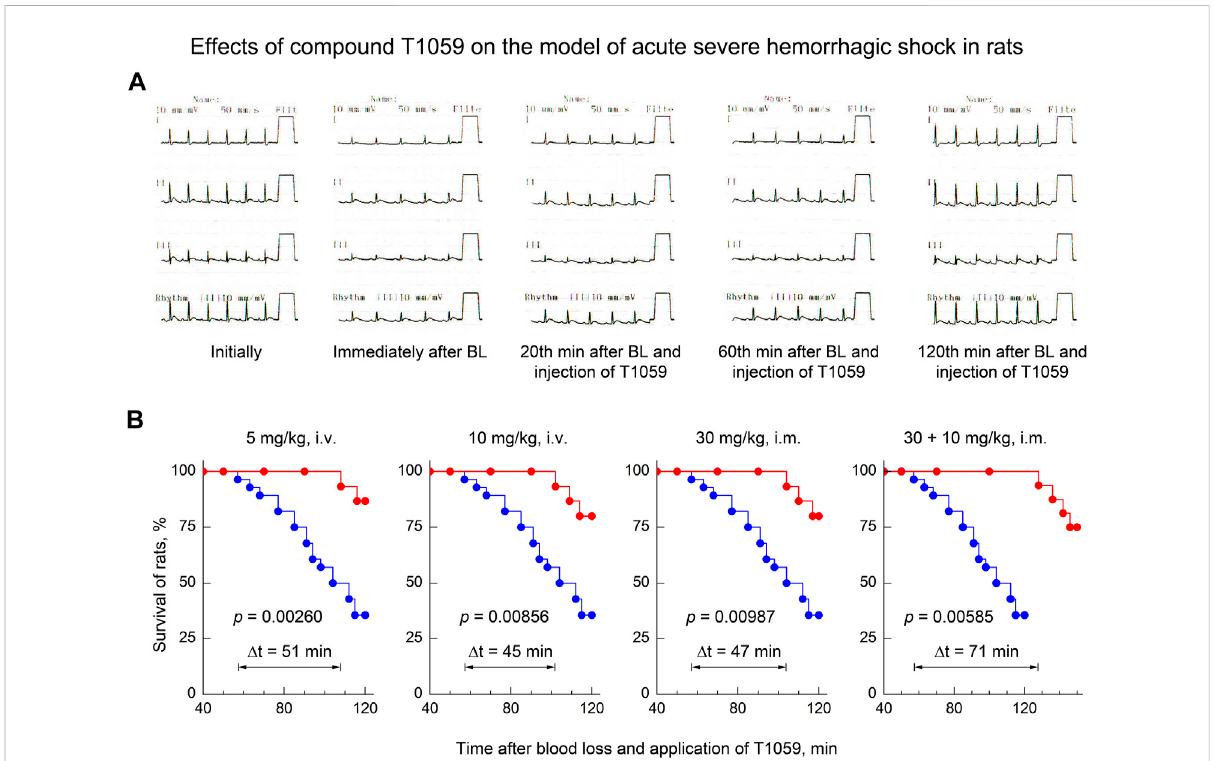
FIGURE 5 Effect of compound T1059 on the clinical course of the early stage of acute severe hemorrhagic shock in rats. (A) Typical cardio-respiratory dynamicsinT1059-treatedrats.Initially:BP — 128/84 mmHg;HF — 424 min-1;sinusrhythm,nochangesintheECG;RF — 58 min-1.Immediatelyafter blood loss (BL): BP — 53/27; HF — 335; sinus rhythm, R-wave depression; RF — 63. 20 min after BL and injection of T1059: BP — 95/66; HF — 372; sinus rhythm, easing of R-wave depression, RF — 60. 60 min after BL and injection of T1059: BP — 120/81; HF — 368; sinus rhythm, no changes in the ECG;RF — 62.120 minafterBLandinjectionofT1059:BP — 115/74;HF — 404;sinusrhythm,moderatesingsofmyocardialischemia;RF — 59. (B) Effect of compound T1059 at different doses and applications on the short-term survival of rats. Red symbols and curves — survival of T1059-treated rats ( n = 15 – 16), blue symbols and curve — survival of untreated rats ( n = 28). Diagrams were plotted using Kaplan-Meier method. p — signi fi cance level of the difference in the survival of T1059-treated vs. untreated rats; Δ t — an increase in time of the non-lethal course of shock when using